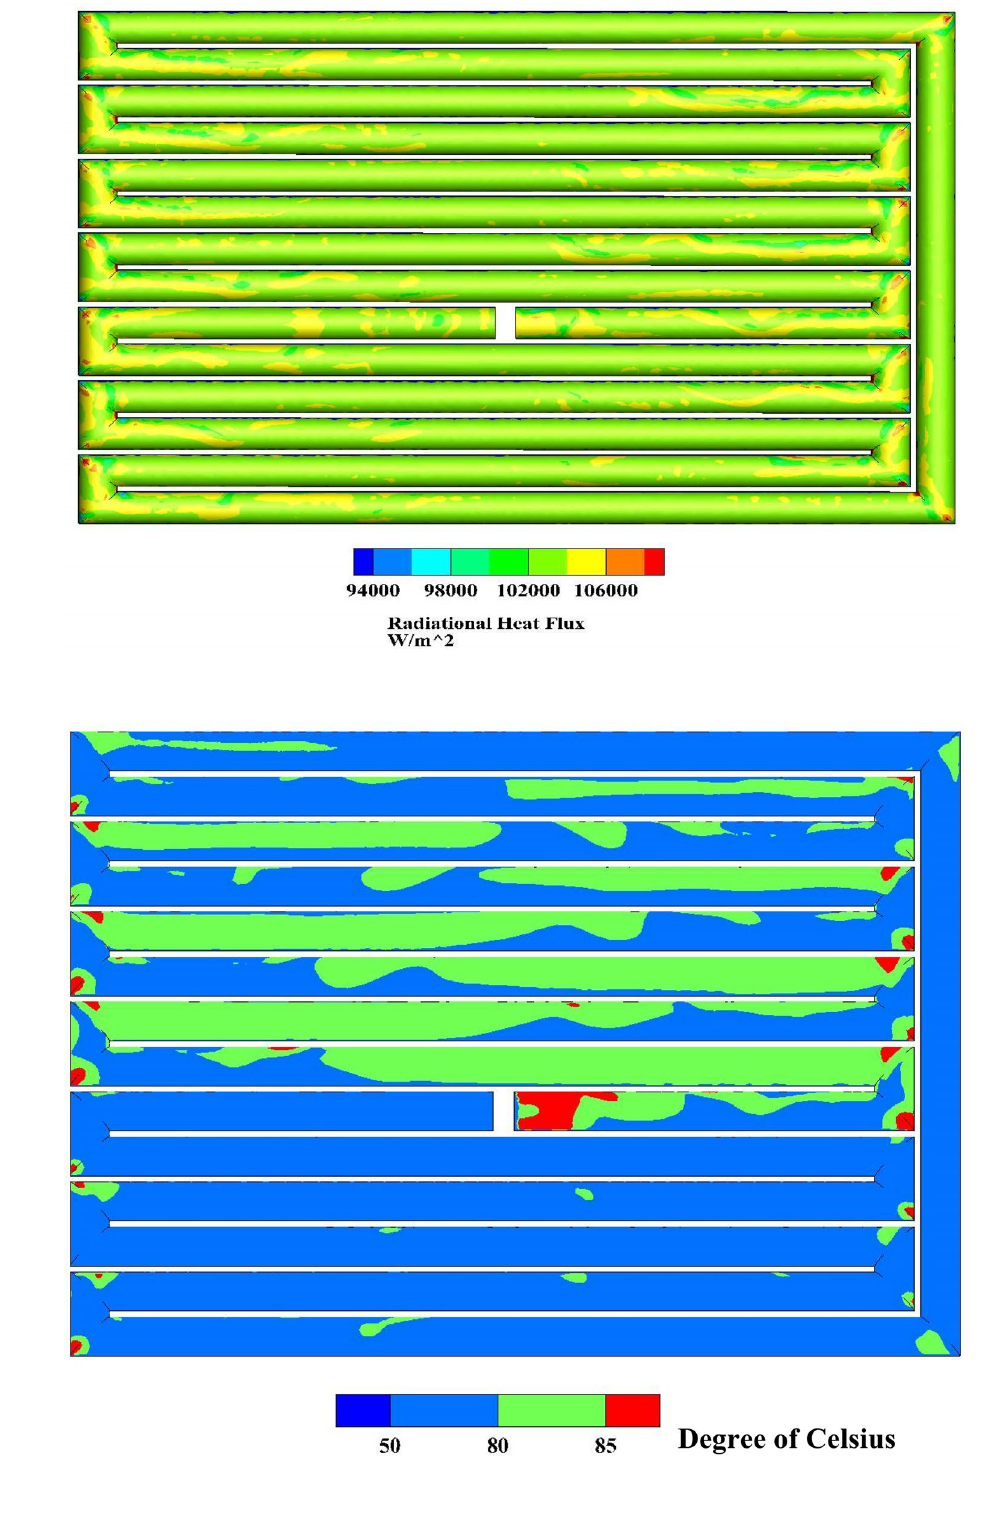
Fig. 13 CFD result of receiving heat flux distribution on the hot-side of WCP